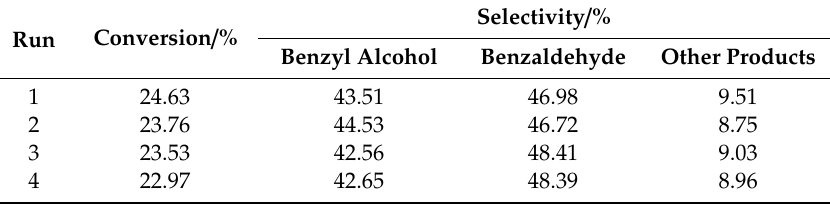
Table 3. Recyclability test for catalyst Mn 3 O 4 / CNTs-3 in the selective oxidation of